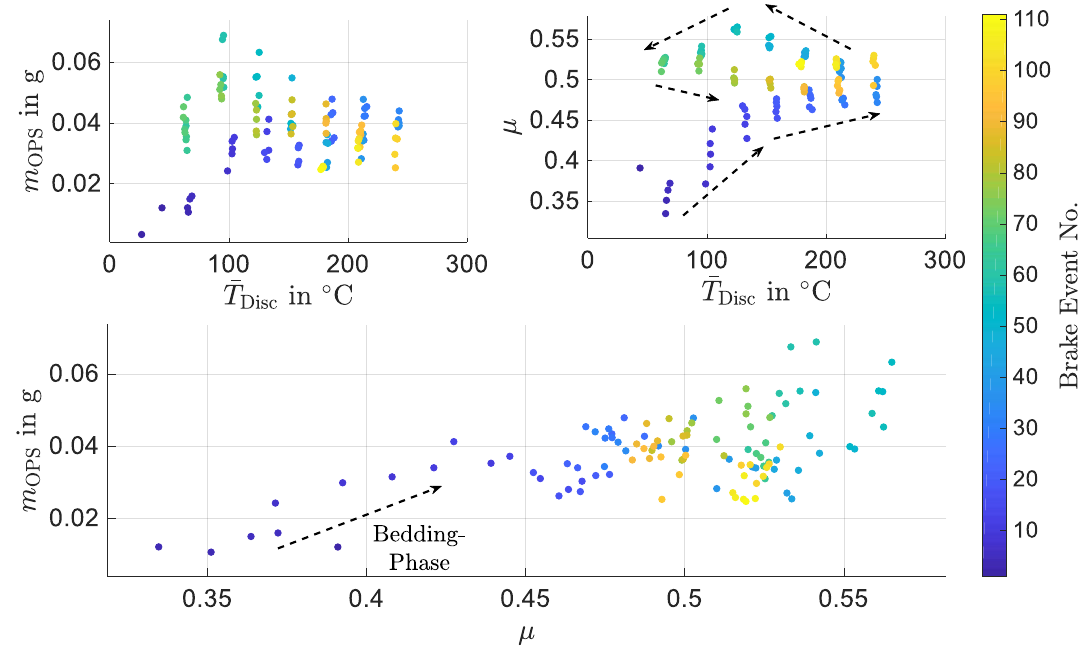
Figure 9. Correlation of PM 10 emission per brake event (calculated by the OPS size distribution and a density of 5.0 g/cm³) average disc temperature T per brake event and the coefficient of friction µ for the pad material with an inorganic binder.